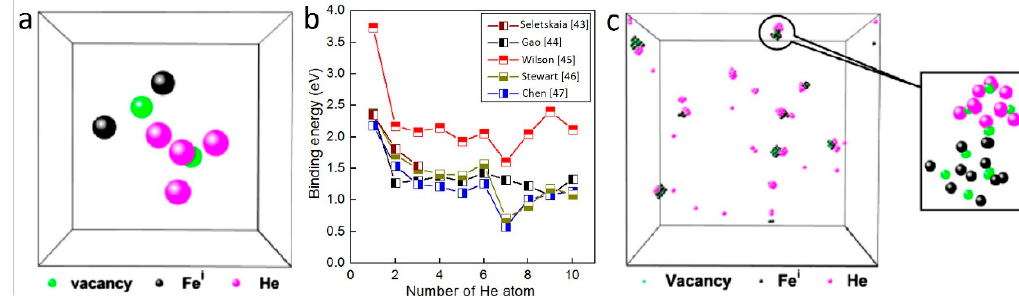
Figure 2. ( a ) Schematic illustration of He–V cluster in Fe [27]; ( b ) the dependence of binding energy of interstitial He to He–V cluster on the number of He atom in He–V cluster [43–47]; and ( c ) He clusters and other defect distribution in Fe containing 125 He atoms. The inserted image is the detailed arrangements of a He-interstitial cluster [27]. Reprinted with permission from [27]; Copyright 2013 Elsevier.